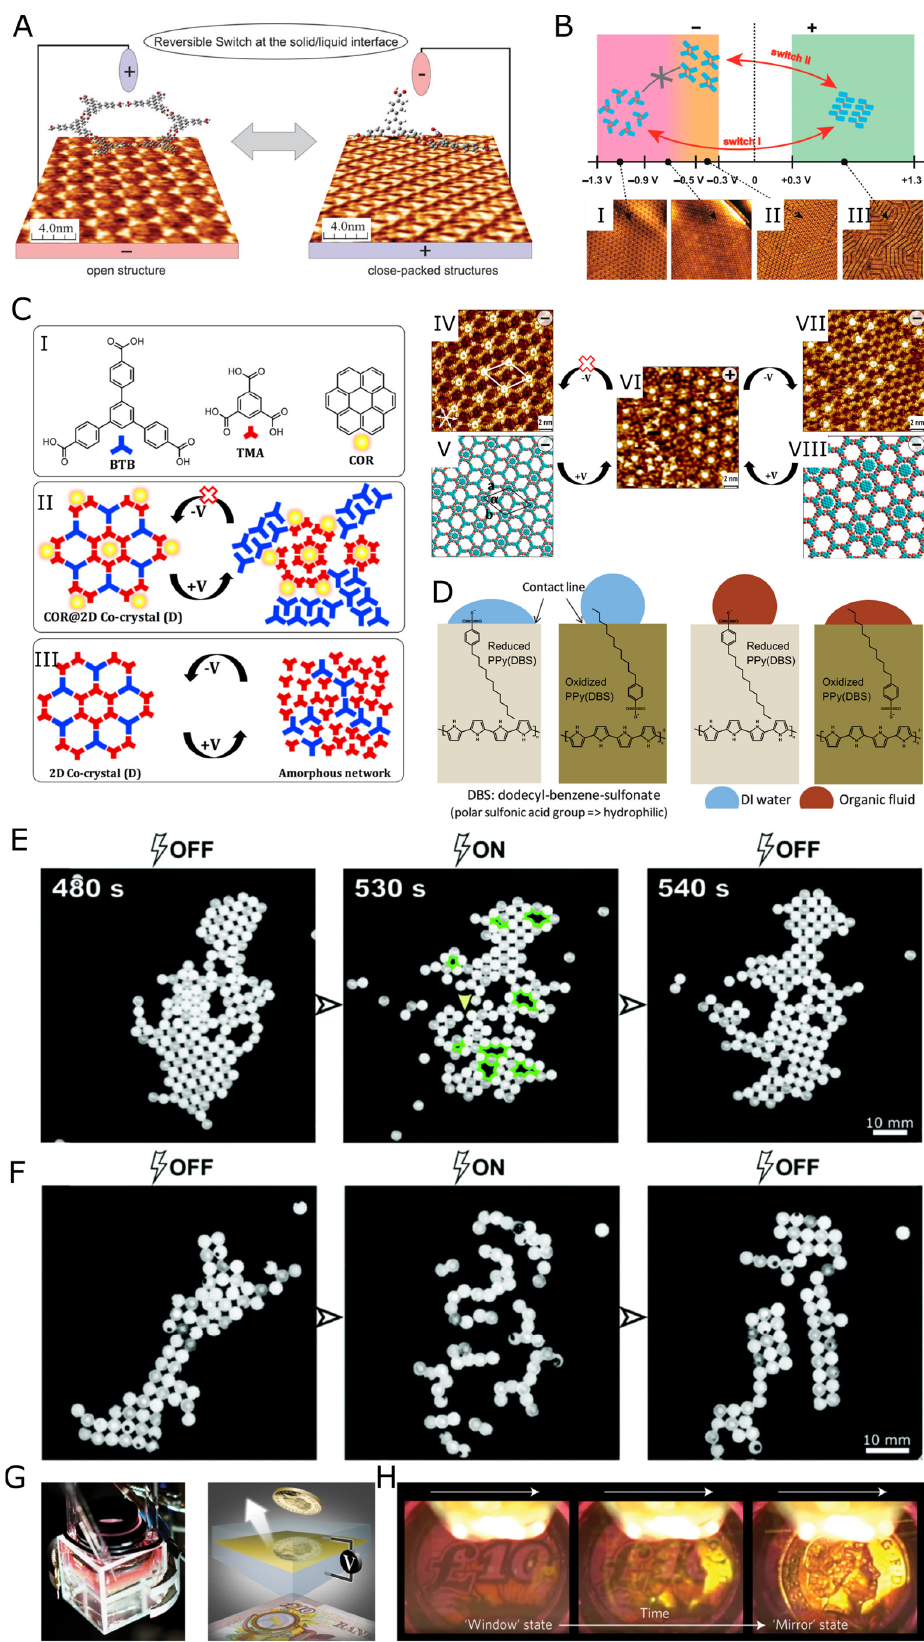
Figure 3. ( A ) Conformational switching of 1,3,5-tris(4-carboxyphenyl) benzene (BTB) between an open and close-packed structure upon application of positive and negative voltage, respectively.